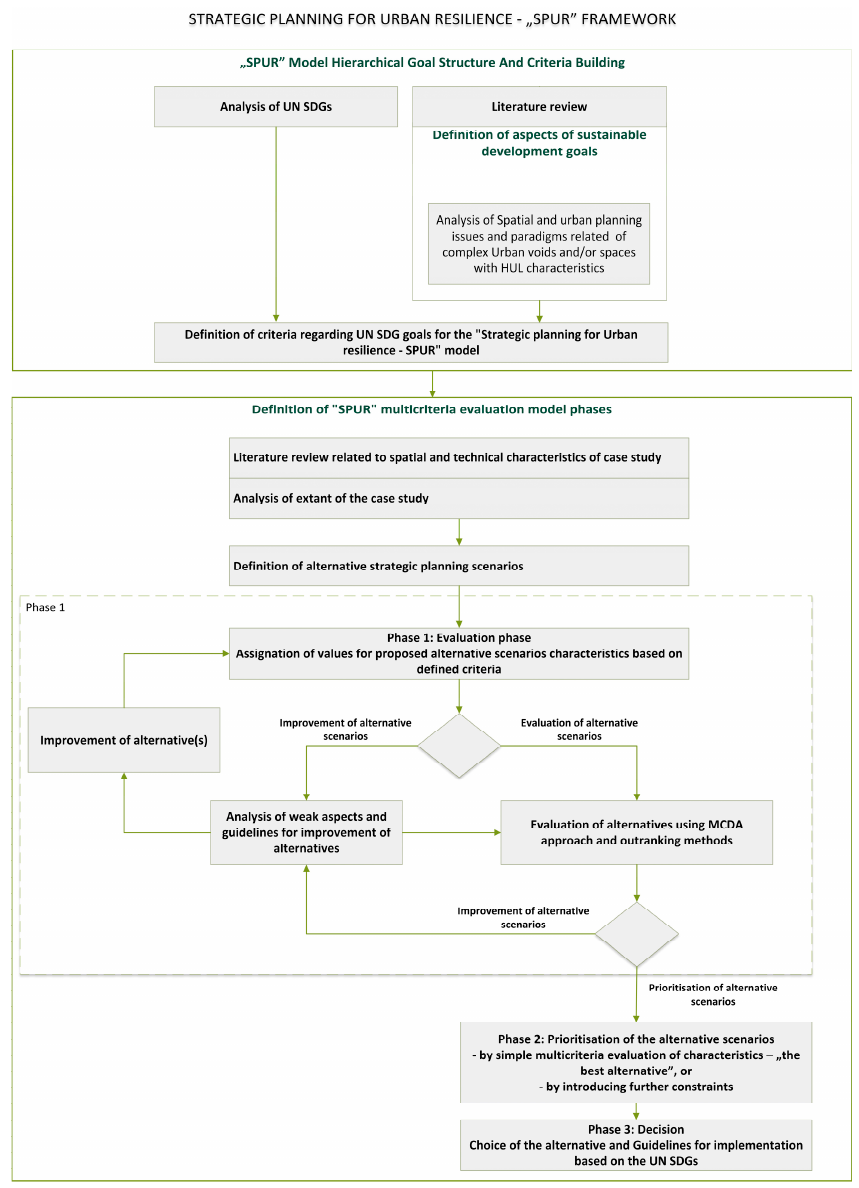
Figure 2. Strategic Planning for Urban Resilience—SPUR model.